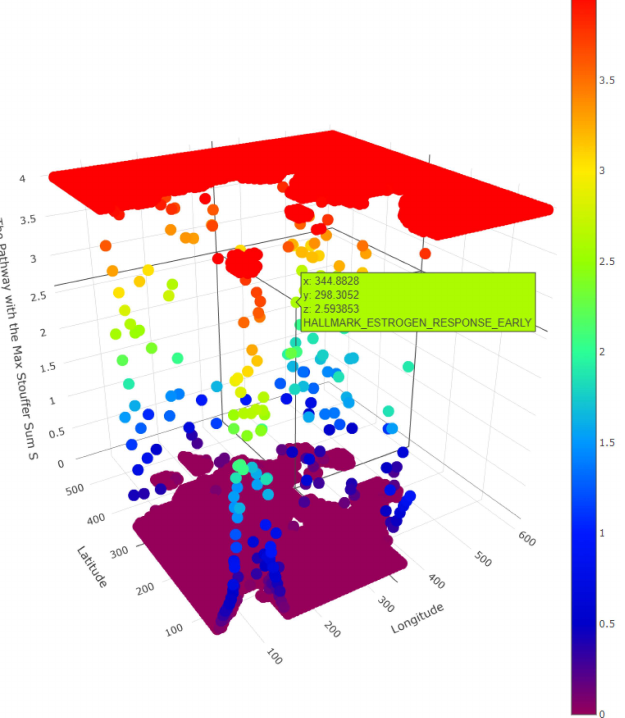
Figure 5. A 3D snapshot of the pointwise dominant hallmark gene sets of cancer. The x and y dimensions define the tissue space while the z dimension represents the maximum spatial enrichment z score ( SEZ ) at a given point among the selected hallmarks. One such point where PI3K_AKT_MTOR hallmark is dominant is shown as an